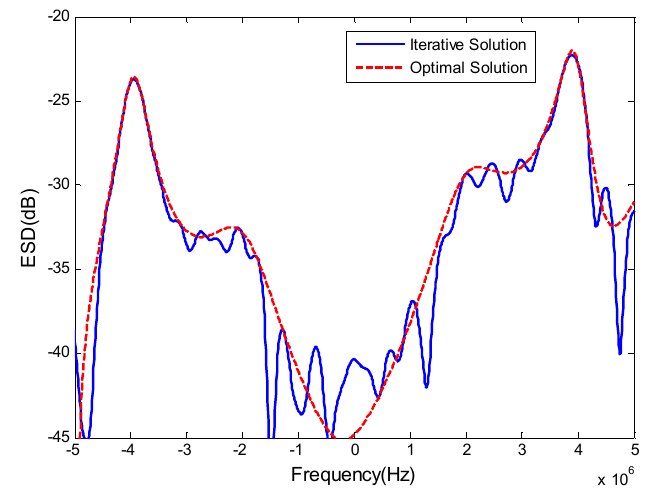
Figure 3. ESD of the optimal transmit waveform and the phase-modulated waveform.